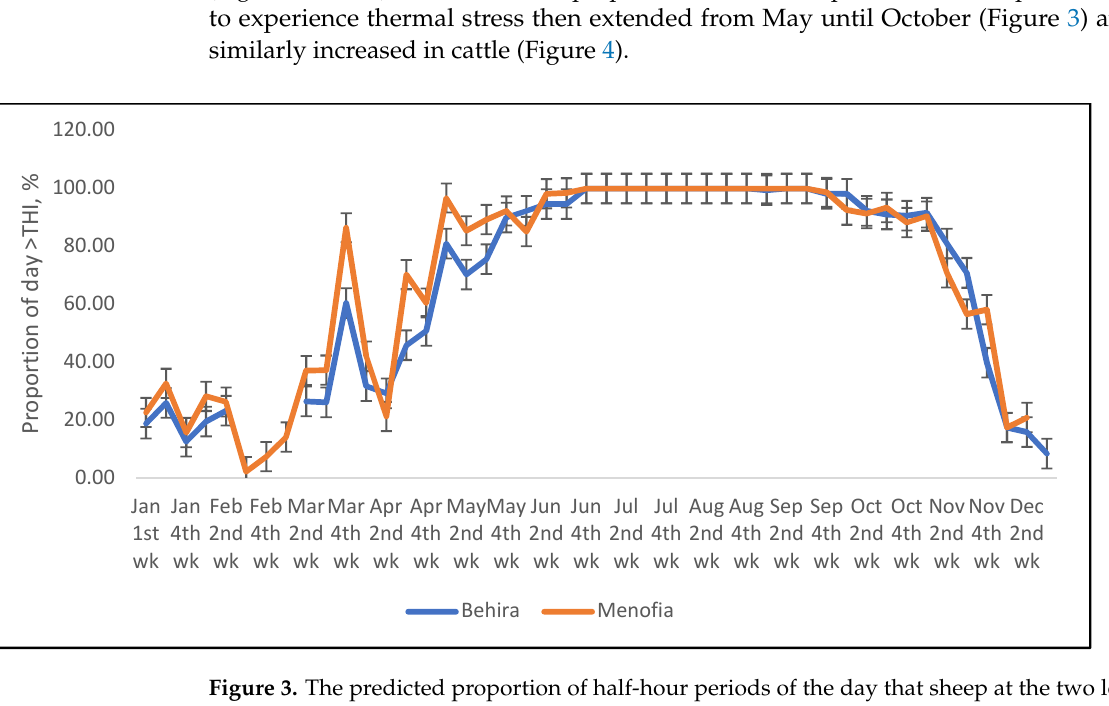
Figure 3. The predicted proportion of half-hour periods of the day that sheep at the two locations (Behira and Menofia) are likely to experience THI greater than that believed to cause heat stress, after addition of temperature increment expected from climate change [38].